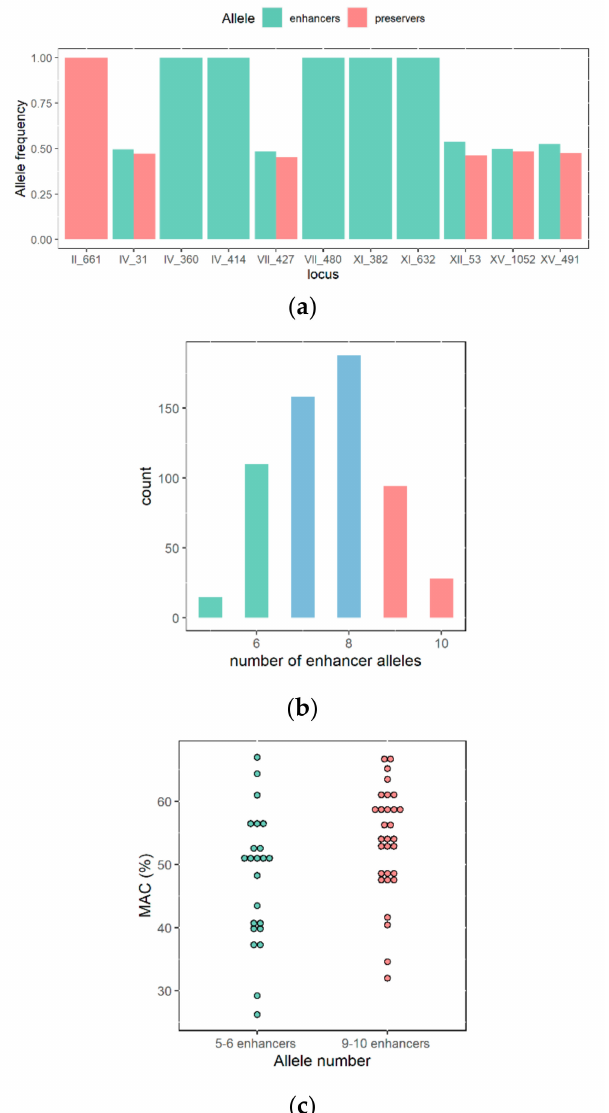
Figure 3. Marker assisted selection of FMGS-1 progeny for five segregating alleles. ( a ) Allele frequency in the progeny, enhancer and preserver alleles are shown in green and red, respectively. ( b ) Distribution of the number enhancer alleles counted in the FMGS-1 progeny (593 fully genotyped progenies). ( c ) Phenotypic difference between progenies having enriched and minimized number of enhancer alleles; values indicated represented the average percentage of Malic acid Consumed (MAC) for each strain (3